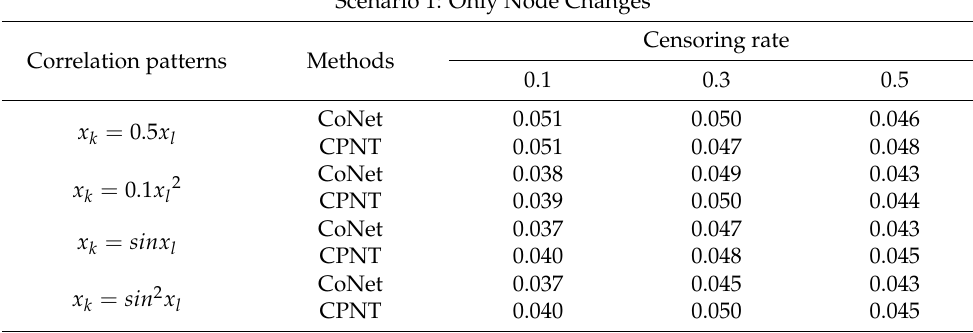
Table 2. The type I error for detecting the effect of the node on the survival phenotype under three scenarios where the effecting node is pre-specified ( n = 5000), with the SNP effect obtained from DPR model. Simulations were conducted with four different between-node correlation patterns (the combination of sine and quadratic, sine, quadratic, and linear) and three different censoring rates (0.1, 0.3, and